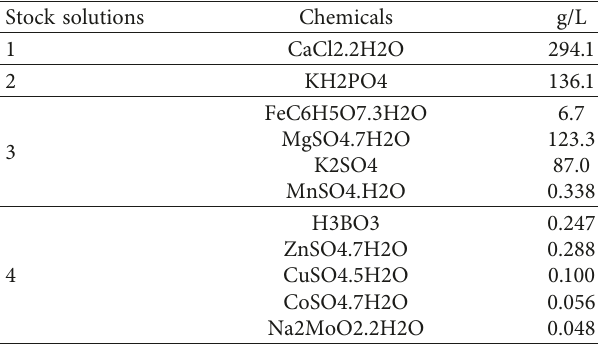
Table 1: Composition of nitrogen-free plant nutrient solutions